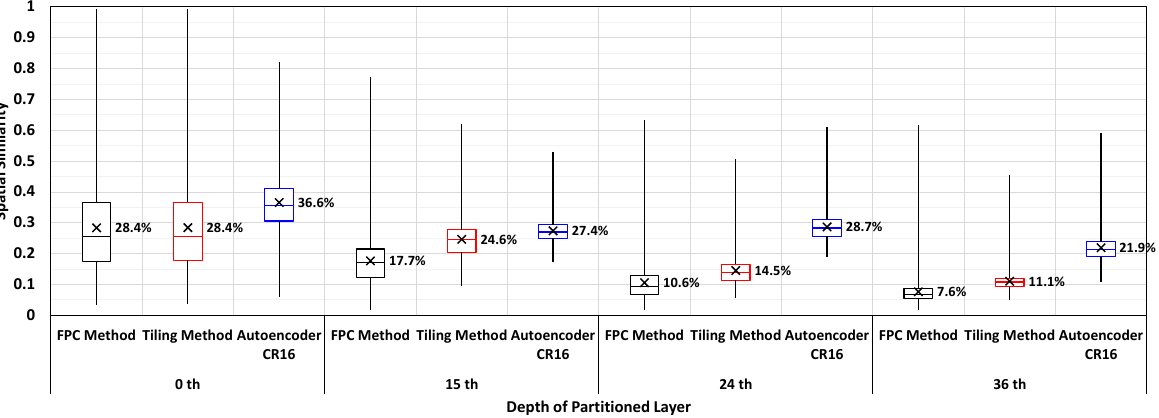
Figure 4. Spatial similarity result of YOLOv3 network at different partitioned